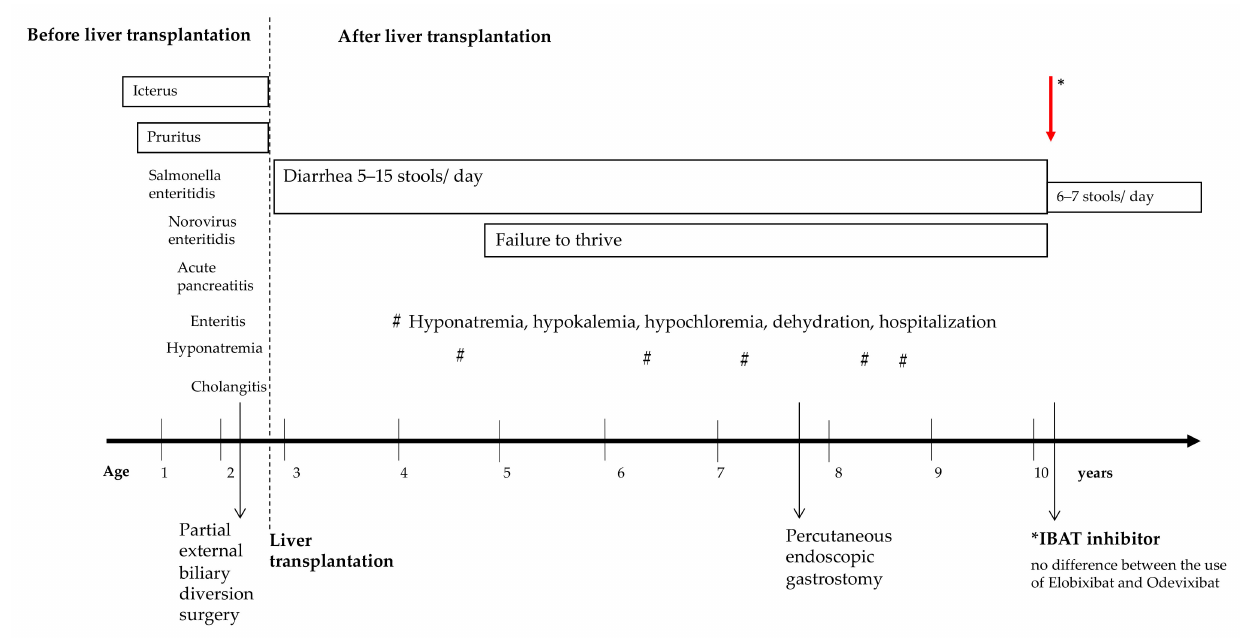
Figure 1. Life before and after liver transplantation over 10 years. IBAT, ileal bile acid transporter